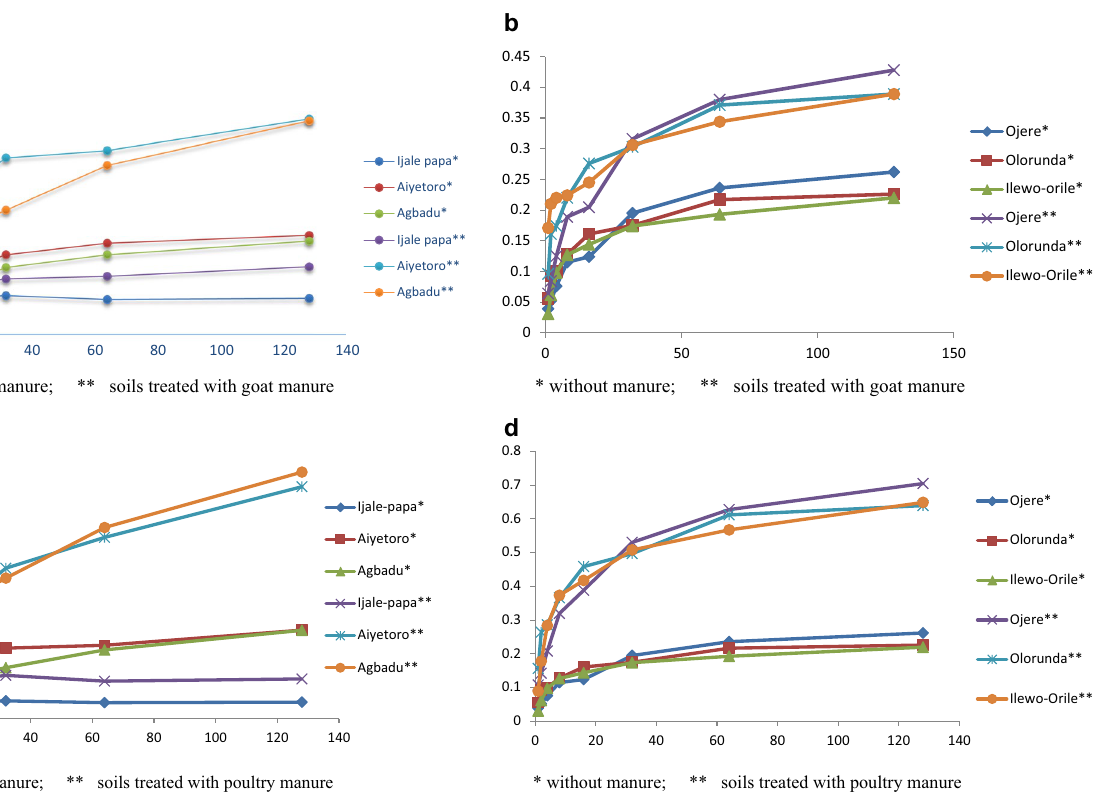
Fig. 1 a Potassium released from Ijale–Oapa, Aiyetoro, and Ipetu- modu/Agbadu soils. b Potassium released from Ojere, Olorunda, and Ilewo–Orile soils. c Potassium released from Ijale–Papa,Aiyetoro,